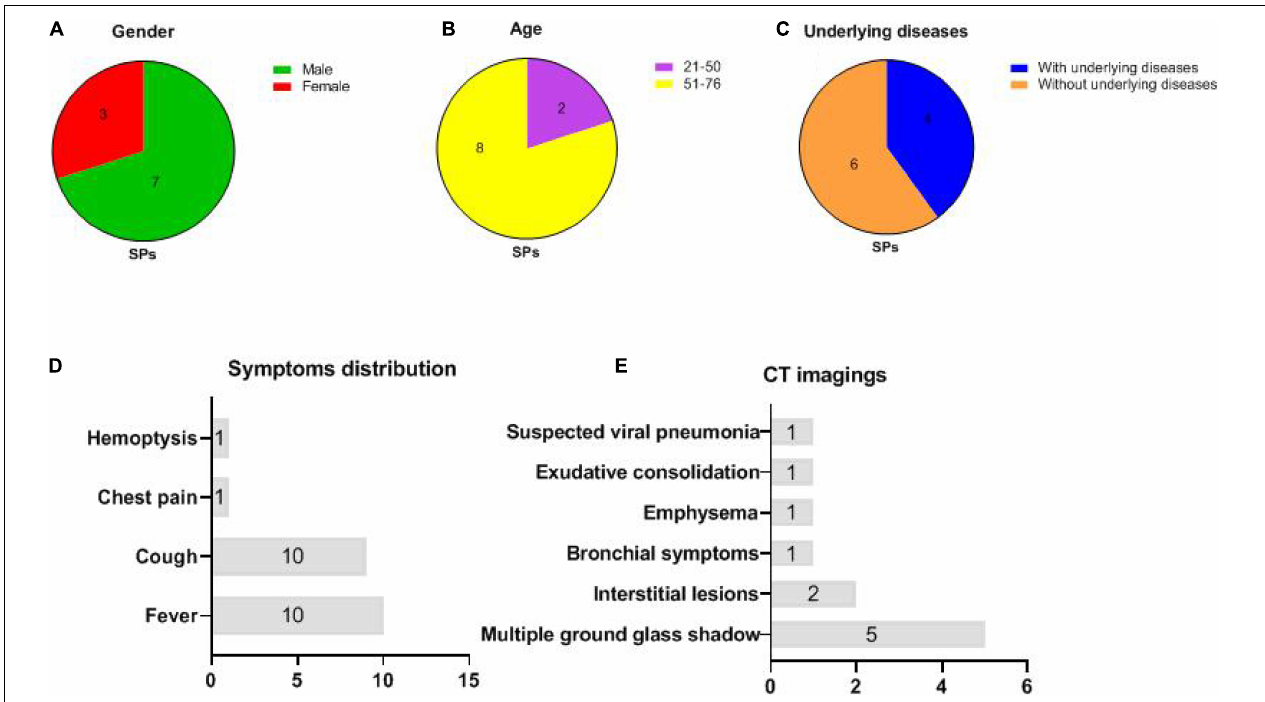
FIGURE 1 | Basic information and clinical manifestations of 10 symptomatic patients (SPs) (same abbreviations in subsequent figures). (A) Gender distributions of SPs: 3 women and 7 men. (B) Age distributions of SPs: 8 individuals were between 51 and 76 while 2 individuals were between 21 and 50 years old. (C) 4 SPs with underlying diseases, whereas 6 SPs without underlying disease were recorded. (D) Distributions of clinical symptoms in SPs: fever (10/10) and cough (10/10) were the most frequently recorded. (E) CT imaging: multiple ground glass shadows were seen in 50% (5/10) individuals; interstitial lesions, bronchial symptoms, emphysema, exudative consolidation, and suspected viral pneumonia were recorded.